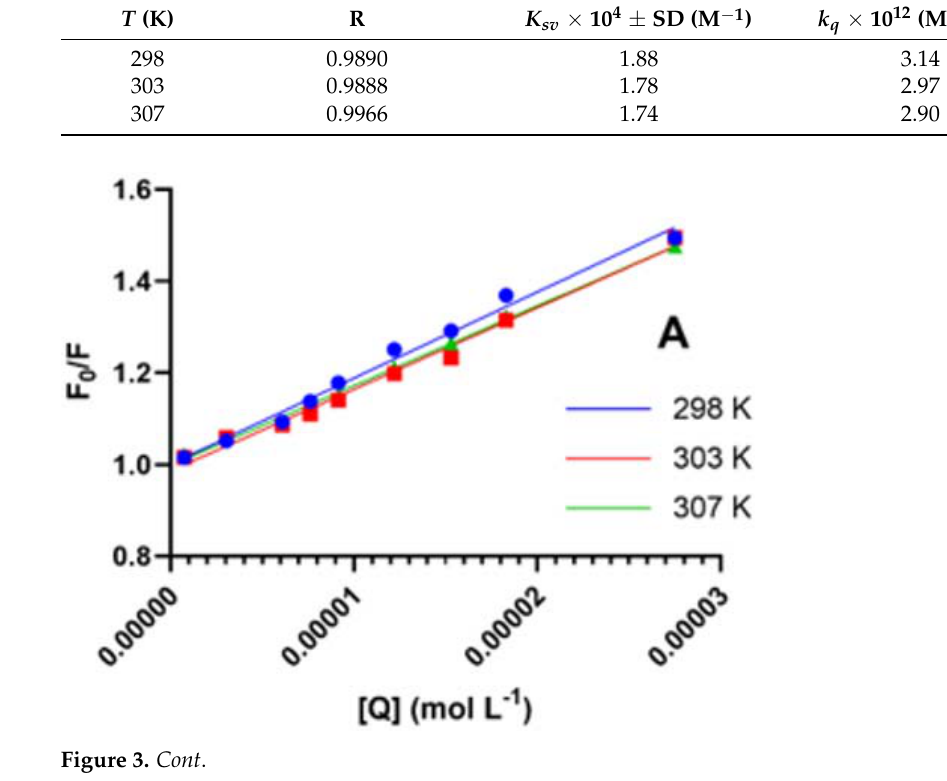
Figure 3. ( A ): Stern Volmer Plot ( B ): binding constant from double reciprocal plot ( C ): van’t Hoff plots for thermodynamic parameters for BSA (1.5 μ M) ‐ ETB (0.00–27.5 μ M) system at 298/303/310 K. The K sv and k q were also evaluated for the ternary system for the BSA ‐ ETB in the pres ‐ ence of RUT, NAR, and SIN (Table 2). The effect of the ternary system was determined by